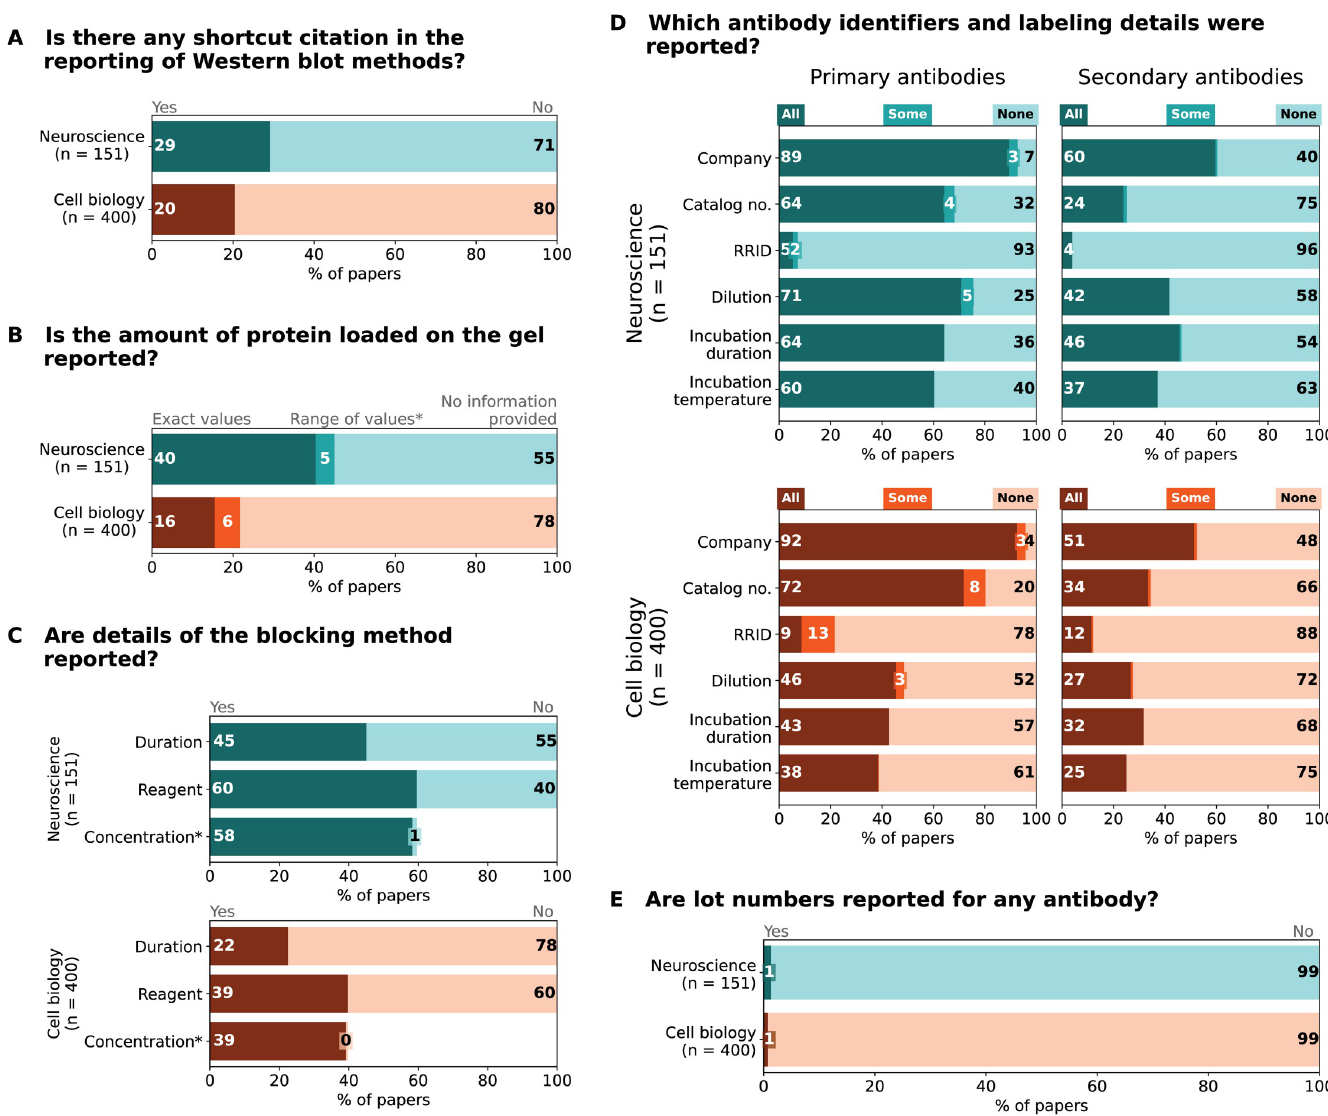
Fig 3. Western blot figures: Prevalence of image display and data presentation practices that may omit information. Bar graphs illustrate the prevalence of (A) full-length blots and uncropped blot source data (the bottom panel bar graphs are conditional to the availability of blot source data in the supplement, i.e., middle panel) and (B) molecular weight (MW) markers and labels as well as the position of MW labels (the middle and bottom panel bar graphs are conditional to the presence of MW labels). Bar graphs in (C) illustrate the prevalence of different types of graphs used to visualize western blot quantification data in scientific publications. � Large sample graph—histogram, box plot, violin plot. �� Other–graphs that do not fall into previous categories, such as line graphs. Papers may contain multiple types of graphs and thus the sum may exceed the total % of papers with graphs. Totals may not be exactly 100% due to rounding. Labels that annotate < 1% are not shown. The data underlying this figure can be found at https://osf.io/2c4wq/ [24].